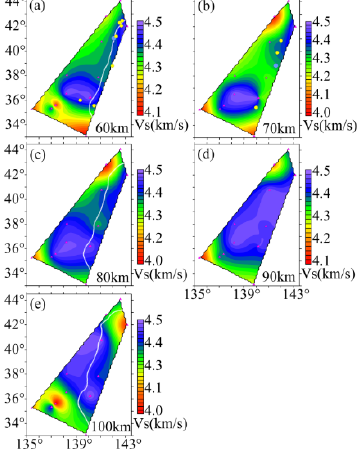
Figure 8: The same as Figure 6, but for the depth of 60 to 100km with 10km